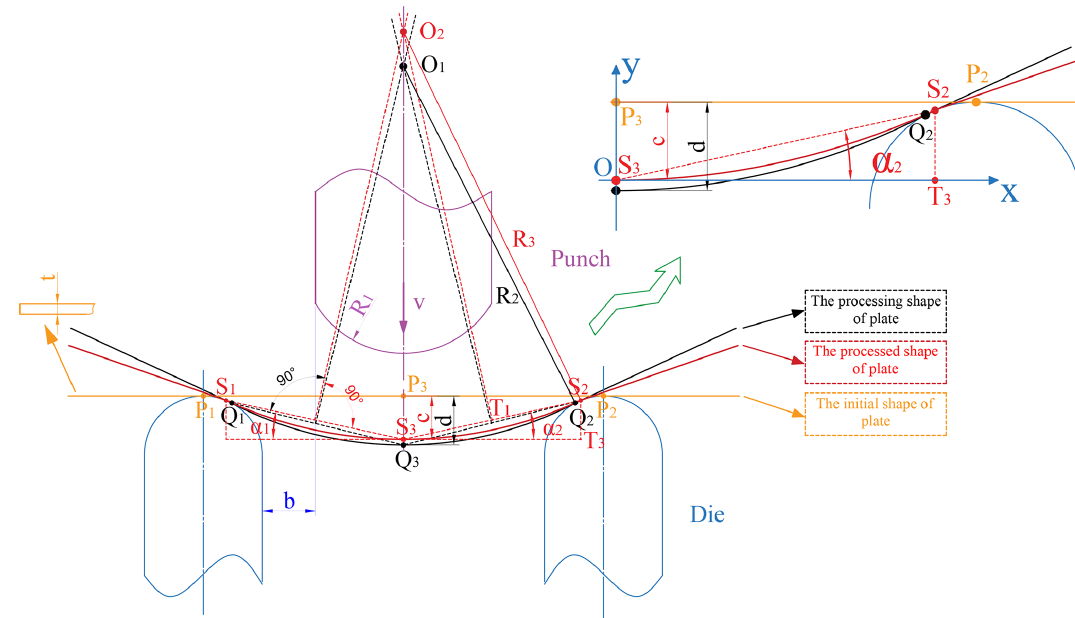
Figure 3. The shape of 2D plate